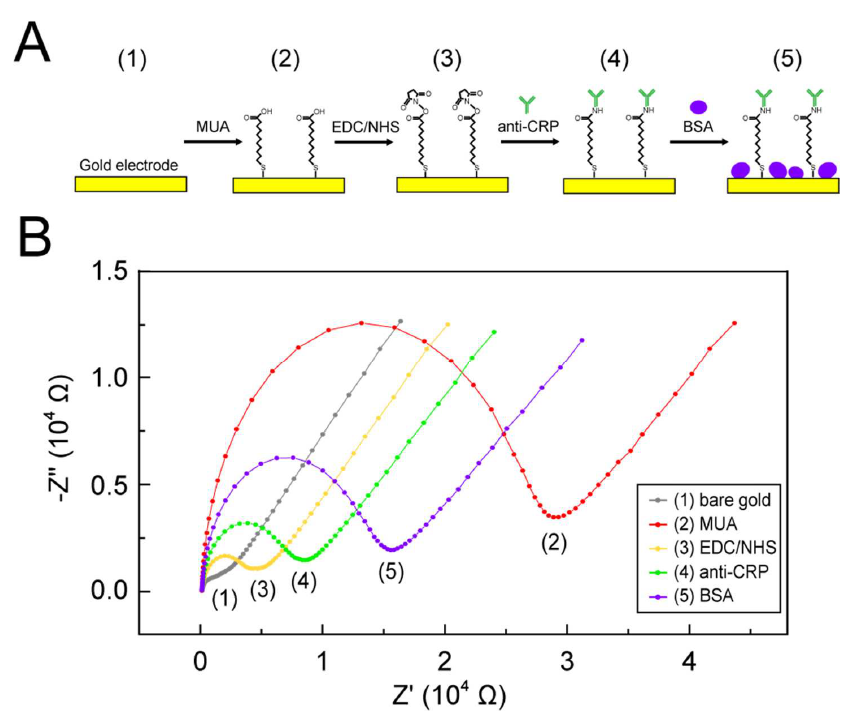
Figure 4. ( A ) The schematic of the EC sensor functionalization protocol. It can be divided into five steps: (1) surface cleaning, (2) 11-MUA self-assembly, (3) EDC/NHS activation, (4) anti-CRP binding, and (5) BSA blocking step. ( B ) The Nyquist plots of EIS measurement at each functionalization step.